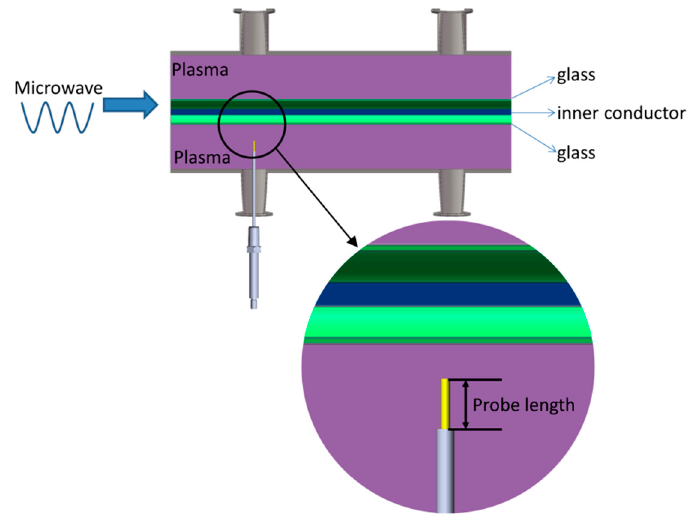
Figure 2. The structure of the coaxial reaction cavity and the Langmuir probe.